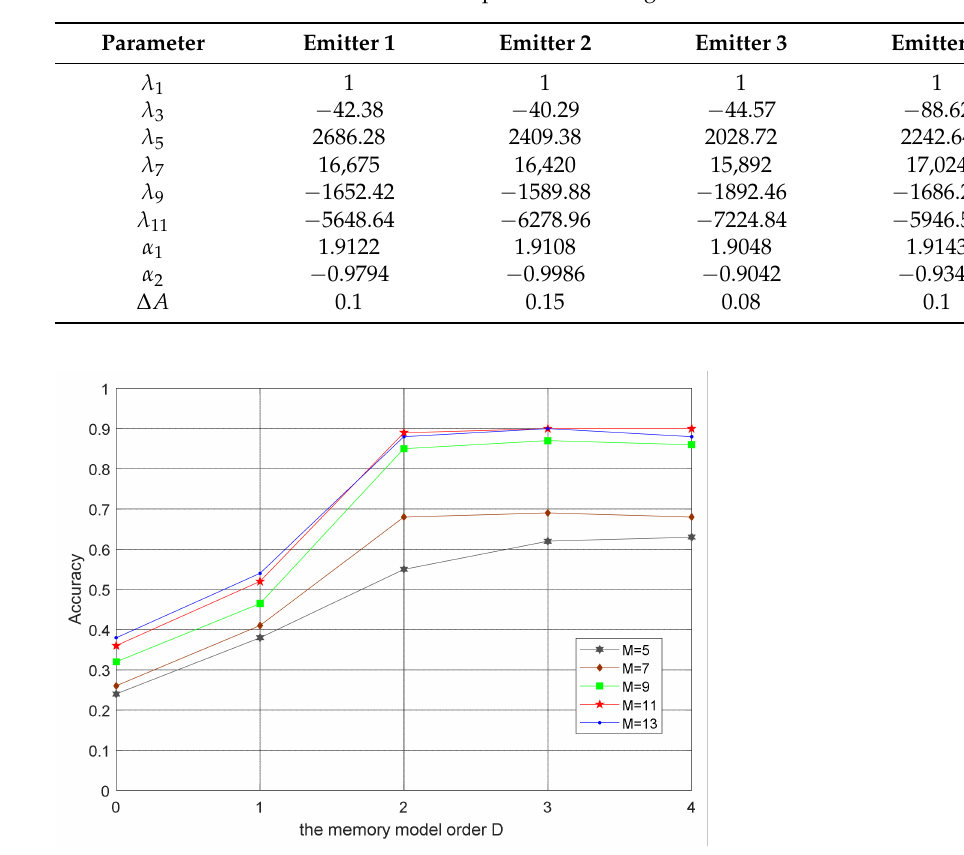
Table 1. ASK-modulated radiation-emitter parameter setting.